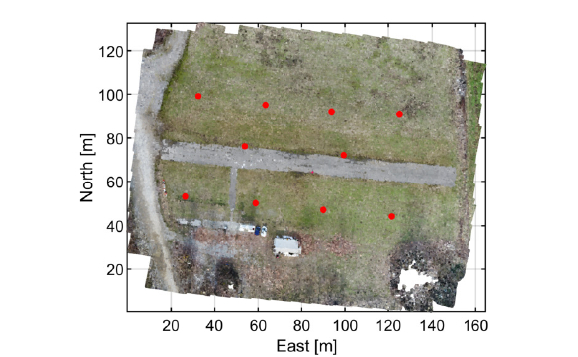
Figure 5. Point cloud of the Rossia case study. The red dots show the location of GCPs.